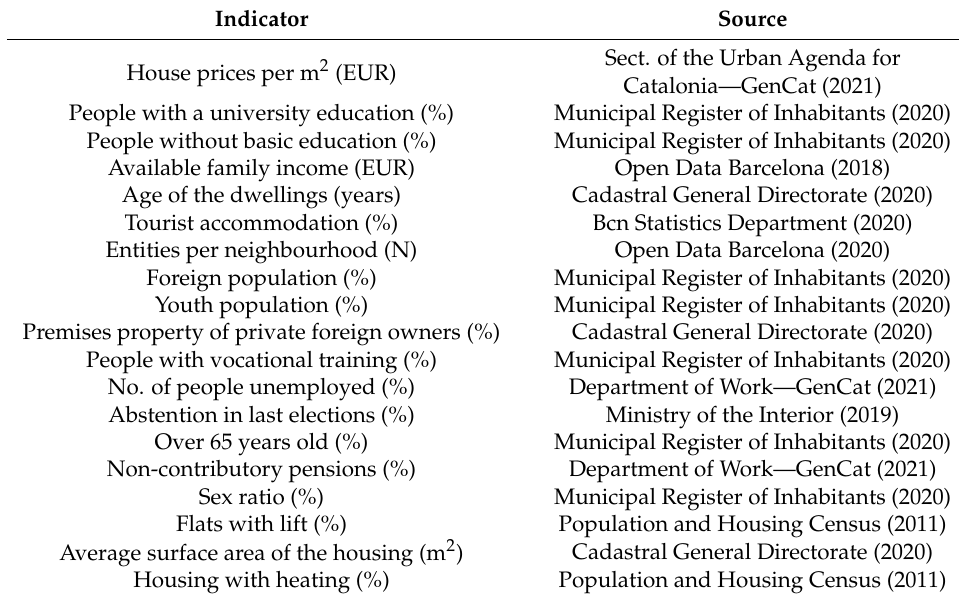
Table 2. Variables selected for the model. Indicator Source House prices per m 2